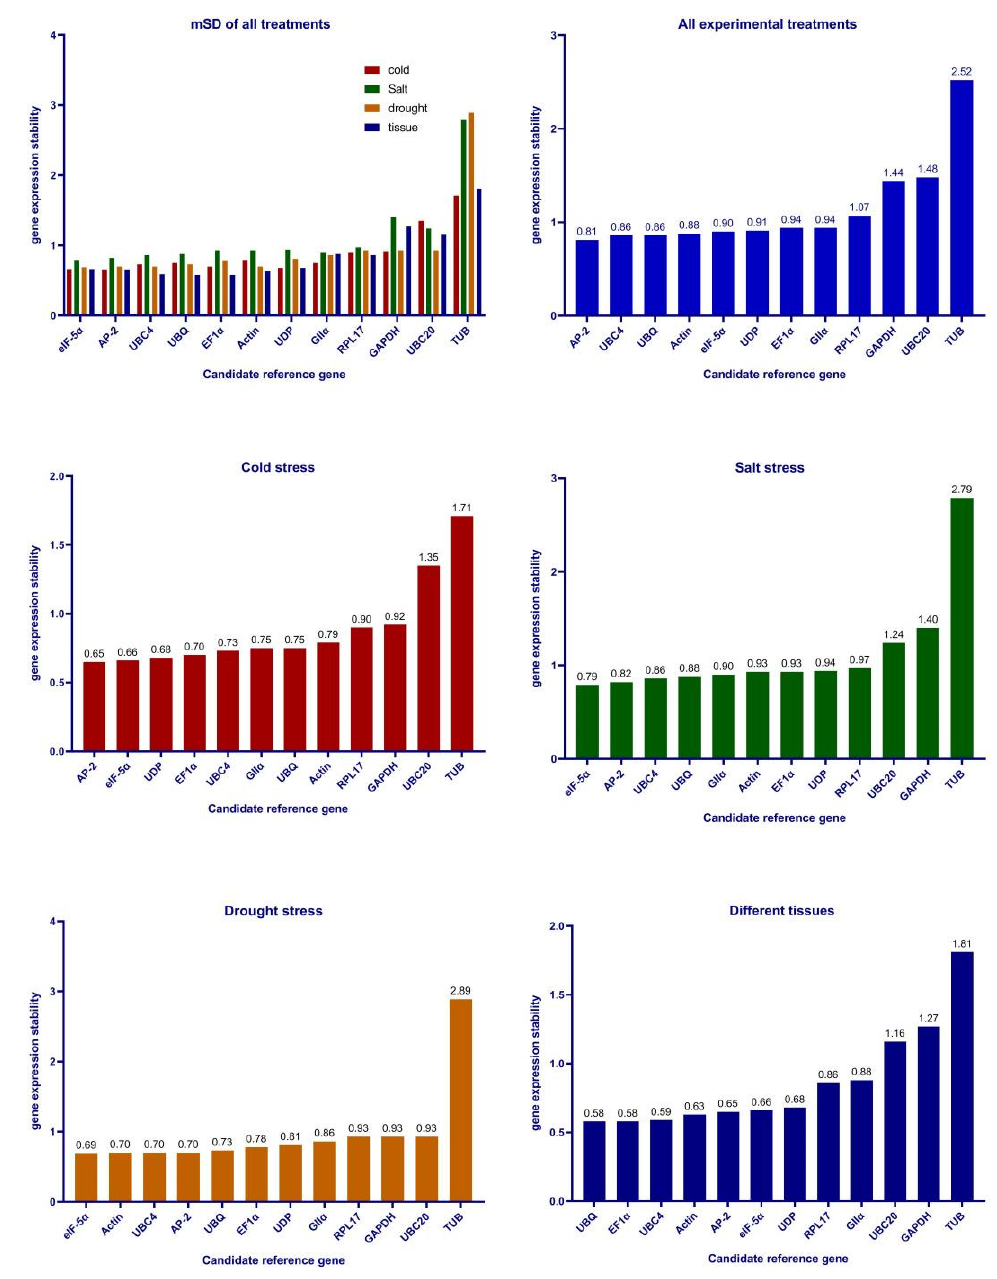
Figure 2. ∆ Ct stability analysis of 12 candidate internal reference Figure 2. Δ Ct stability analysis of 12 candidate internal reference genes.